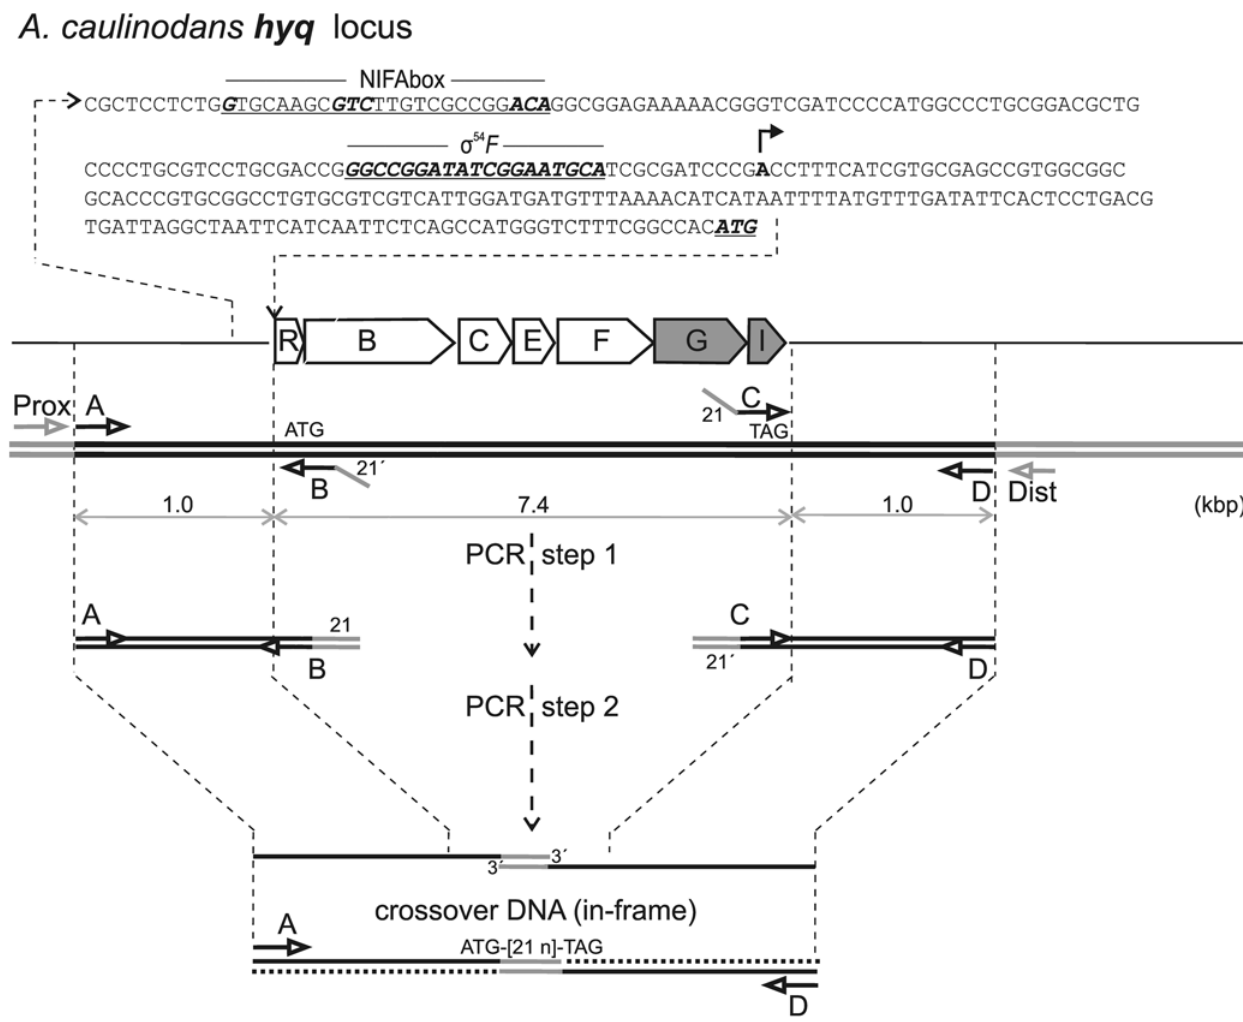
Figure 2. A.caulinodanshyq genetic locus and physical map: creation of in-frame, translational fusion deletions. The main line represents the genetic map of the 7-gene hyq polycistronic operon (7.4 kbp coding DNA). Superimposed above is the , 300 np sequence upstream of the hyqR start (ATG) codon, presumably comprising the hyq control region, which includes a canonical NIFAbox element, facilitating binding of the NIFA transcriptional activator, adjacent to a s 54F-box element, allowing initiation by RNA polymerase ? s 54F complex (see Results). For additional details, please refer to Fig 1.